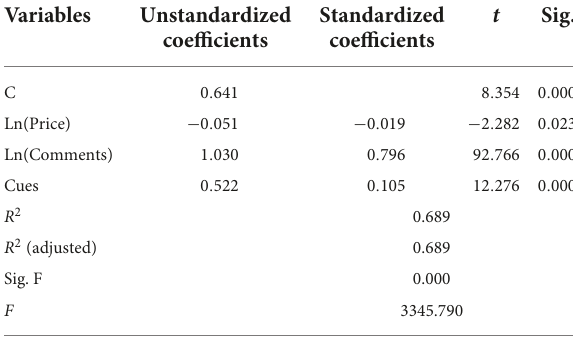
TABLE 3 Results of haptic cues influence in pinch meter